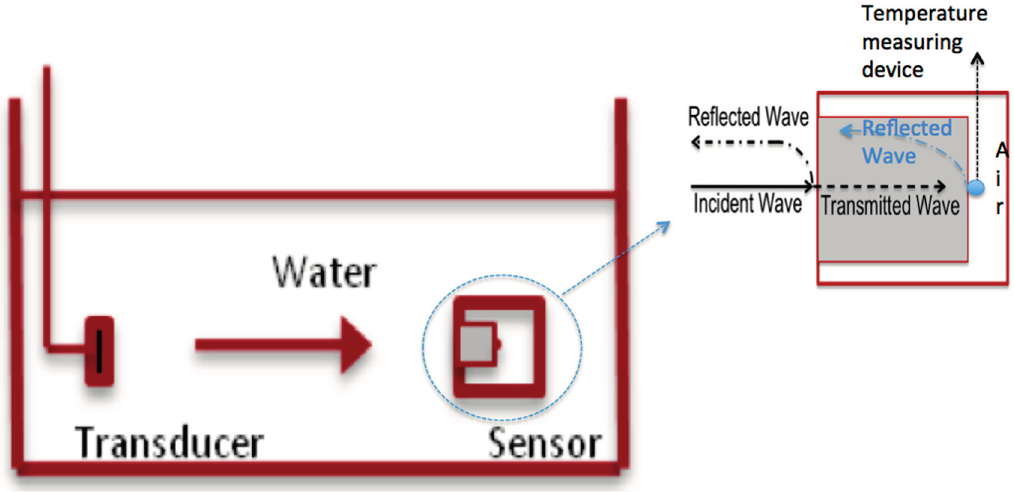
Figure 1. Schematic of the standard thermoacoustic sensor and its